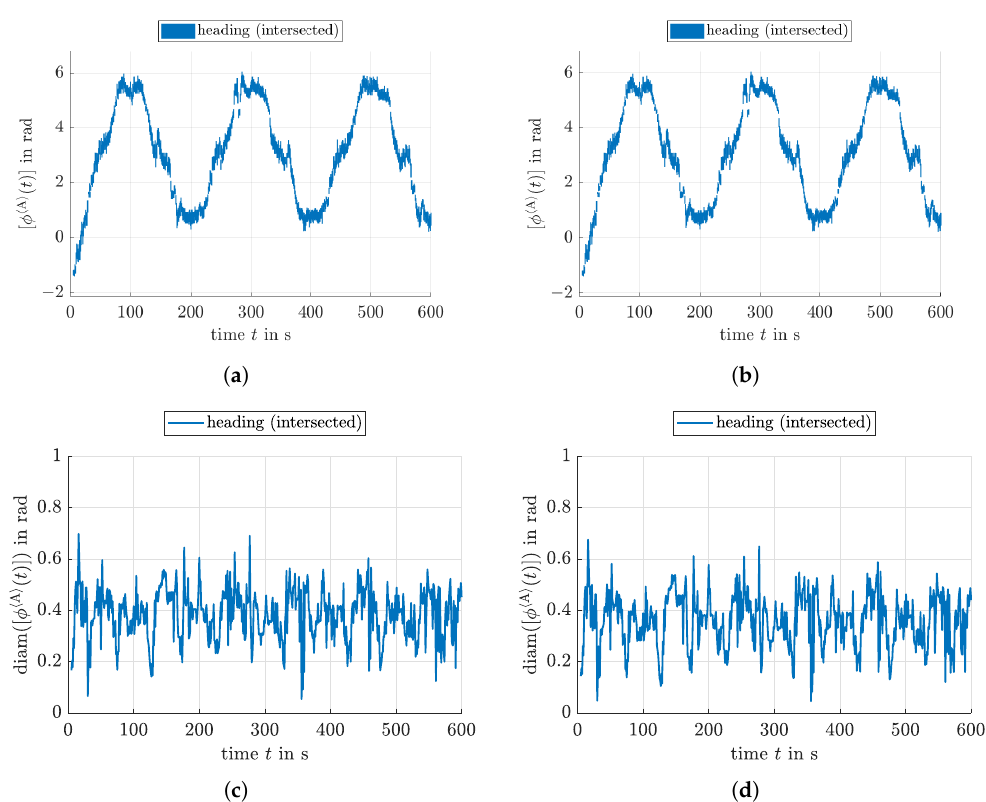
Figure 6. Combination of the information obtained by the compass- and GPS-based heading intervals for the DDboat A. ( a ) Intersection of compass- and GPS-based measurement intervals for DDboat A (constant error bounds). ( b ) Intersection of compass- and GPS-based measurement intervals for DDboat A (time-varying error bounds). ( c ) Interval diameters corresponding to Figure 6a. ( d ) Interval diameters corresponding to Figure 6b. Table 2. Measurement uncertainty (mean of the interval radius of the compass-based heading measurement φ m,c and the GPS-based heading reconstruction φ m,GPS , as well as interval